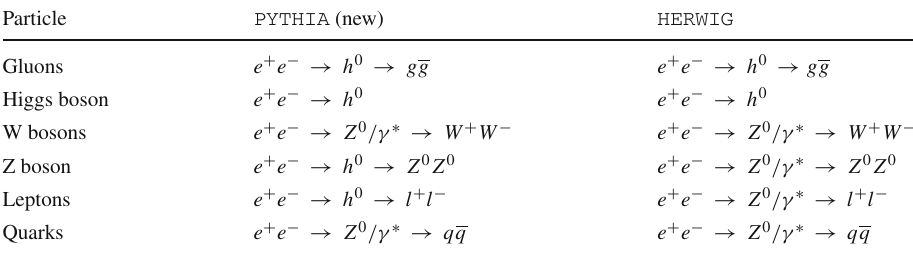
terion: Table 3 for Early Universe/BBN particles ( PYTHIA and HERWIG tables) and Table 4 for present epoch particles Table 1 List of the channels Particle PYTHIA used to compute the hadronization tables